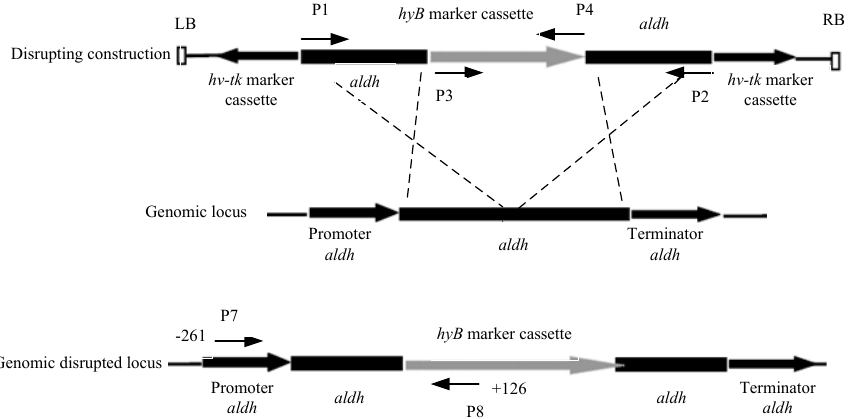
Figure 3. Schematic diagrams of strategy for disruption of F. oxysporum aldh in this study. The numbers indicate the relative translation start codon (A of ATG as +1). P1– P8 indicate the PCR primers used to amplify the aldh and hyB cassette or to